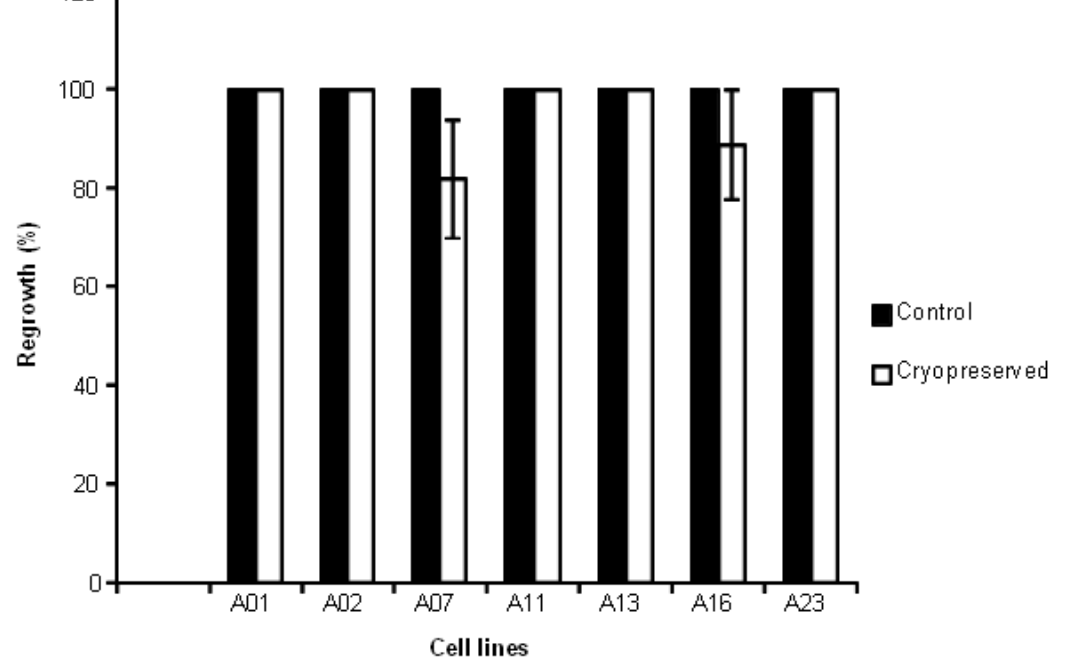
Figure 5. Regrowth (%) of different cell lines after cryopreservation (comparison to control tissue that was pretreated but not cryopreserved); three repetitions, each containing five Petri dishes; bars indicate standard errors.